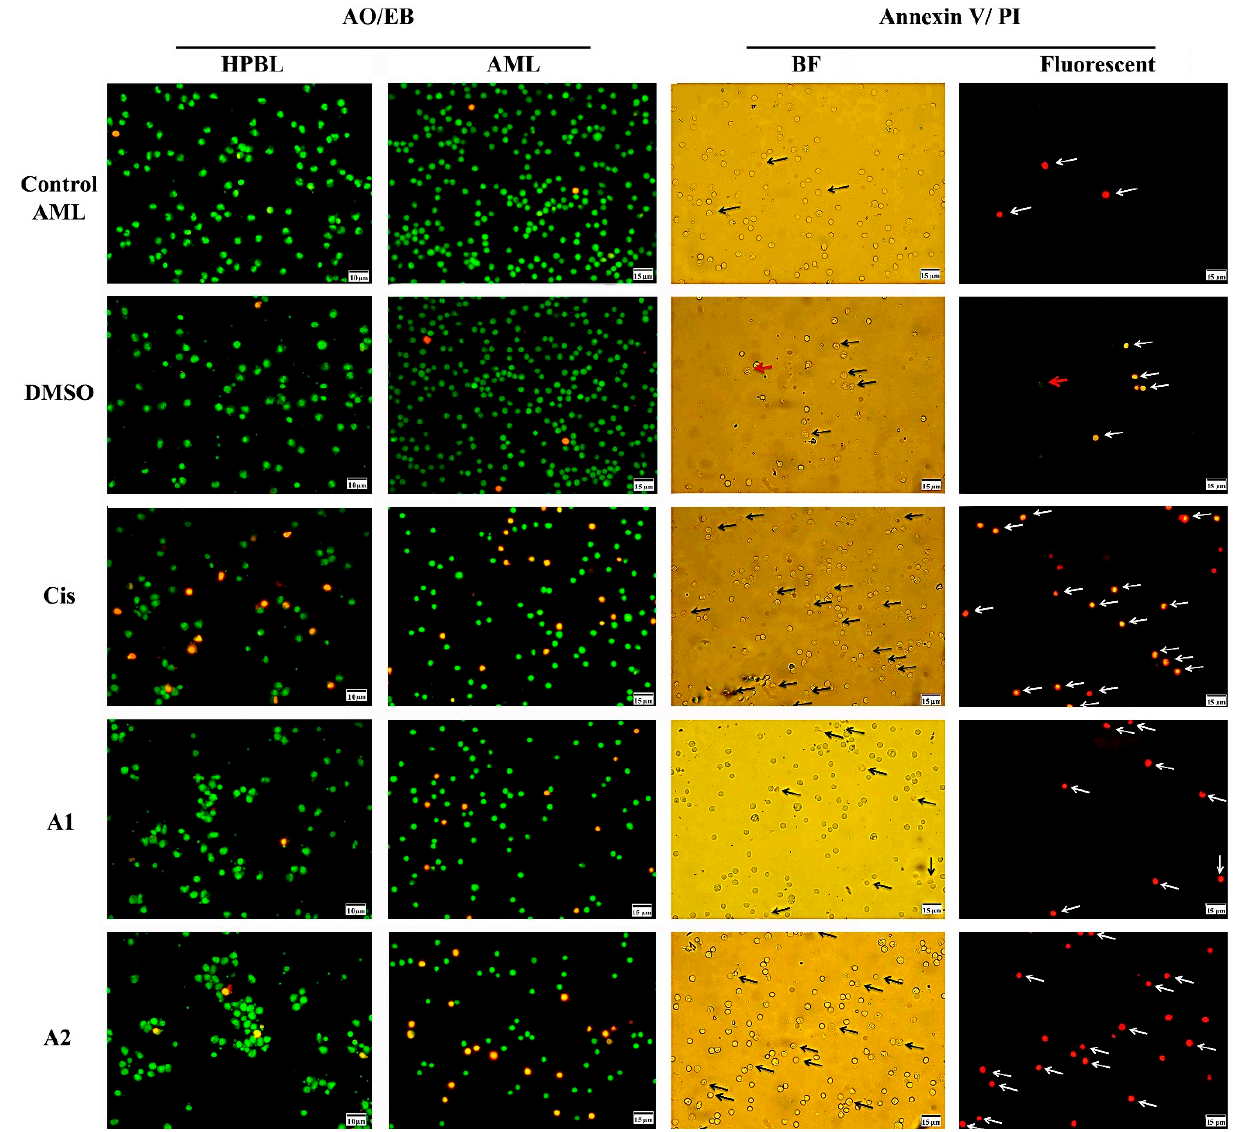
Figure 6. Representative photomicrographs of control and treated AML cells after 3 h of incubation, as observed by an inverted microscope and detected by acridine orange/ethidium bromide (AO/EB) dual-fluorescent staining. Assessment of necrotic or late apoptotic cell death as detected by Annexin-V/Propidium.